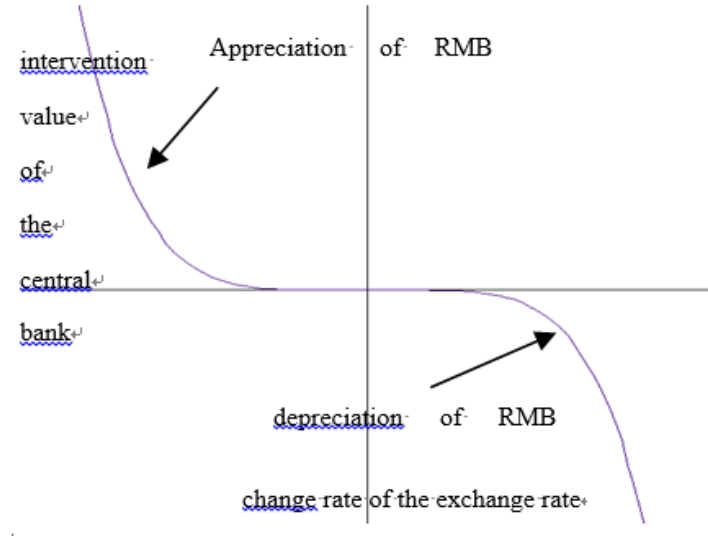
Fig. 2 The Intervention of the Central Bank under the Range Quadratic Preference